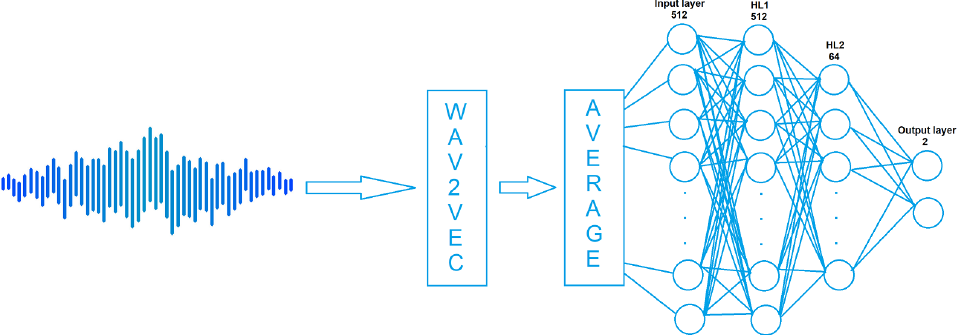
Figure 3. Structure of our SGR